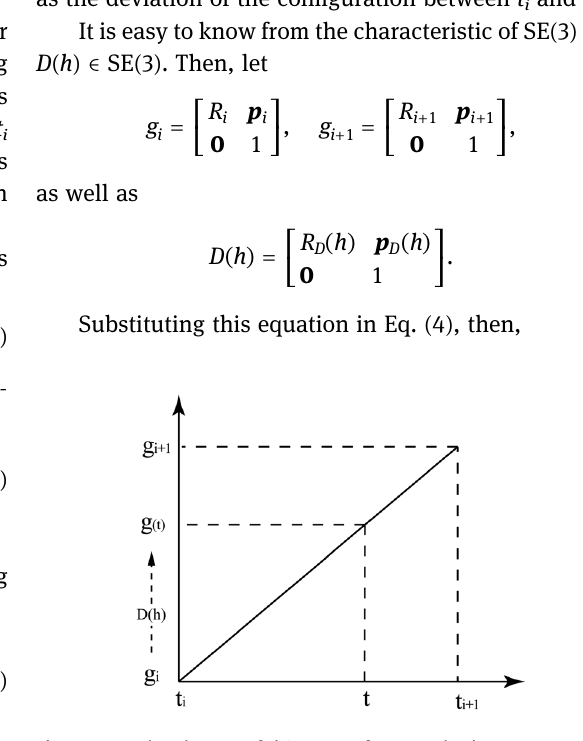
Figure 2: A sketch map of drive - transform